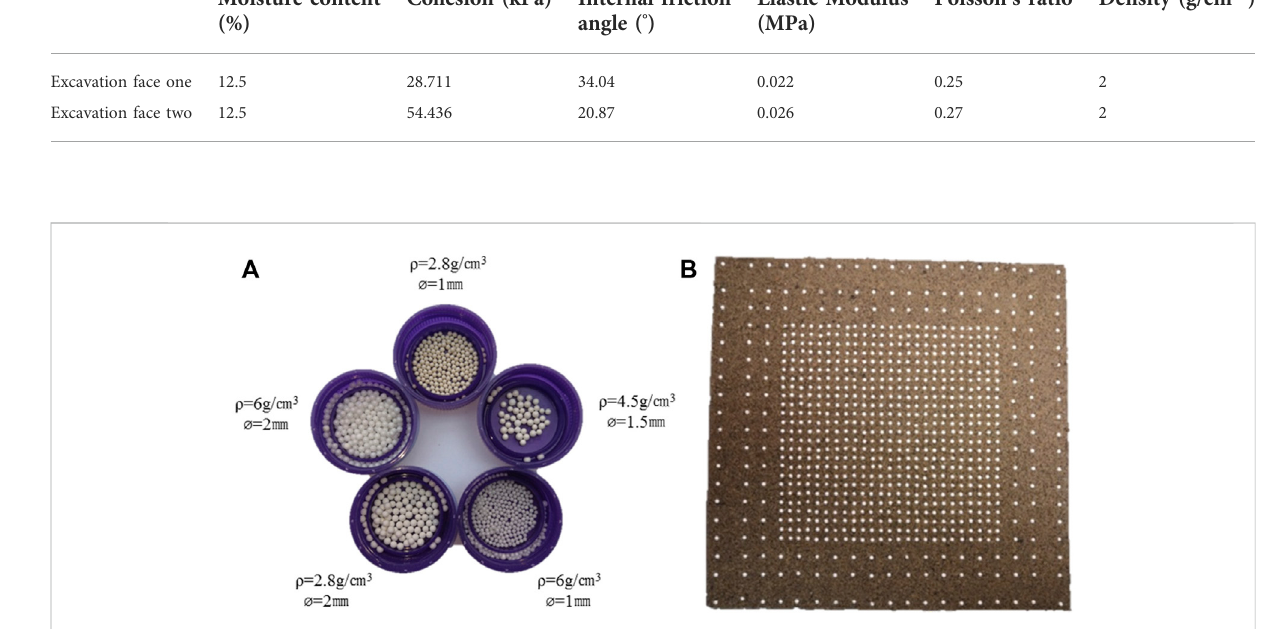
FIGURE 2 Marker selection effect: (A) Marker comparison, (B) Marker placement